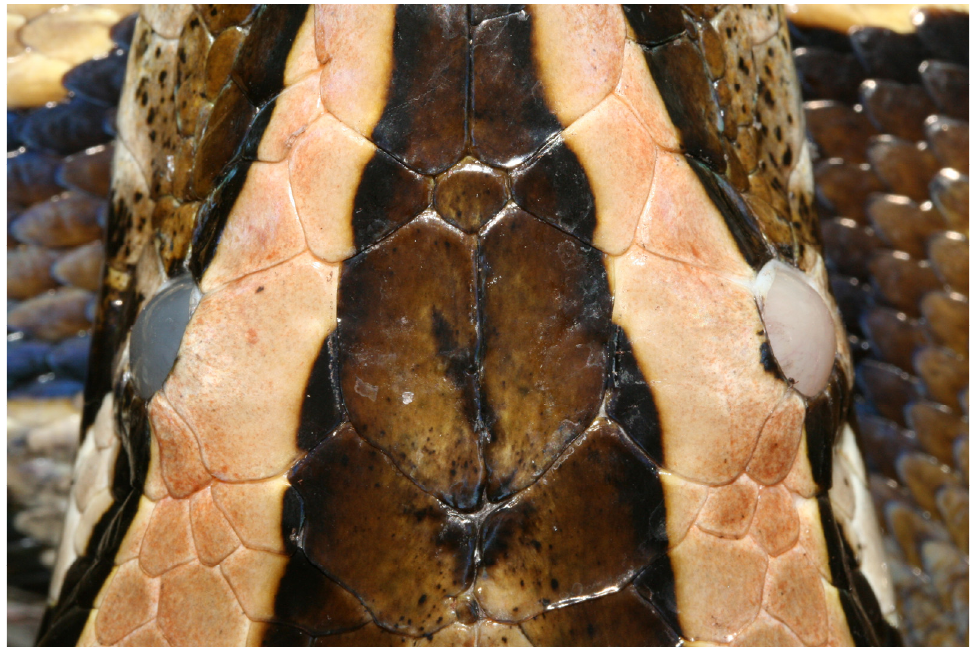
Figure 11. Bilateral opacification of the spectacle in a Burmese python ( Python bivittatus ). The blueish hue of the left spectacle is related to the renewal phase of the skin, whereas opacification of the right spectacle is caused by the presence of flocculent exudate in the ipsilateral subspectacular space due to bacterial infection.